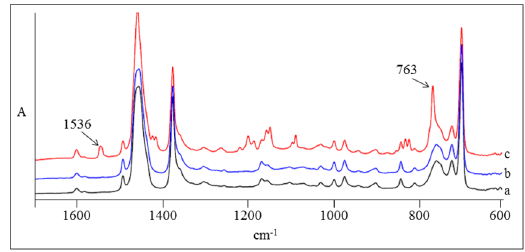
Figure 3. FTIR-ATR in the region from 1700 -1 to 600 cm -1 of samples (a) Standard, (b) 1.5% AgNano and (c) 1.5% ZnPT.